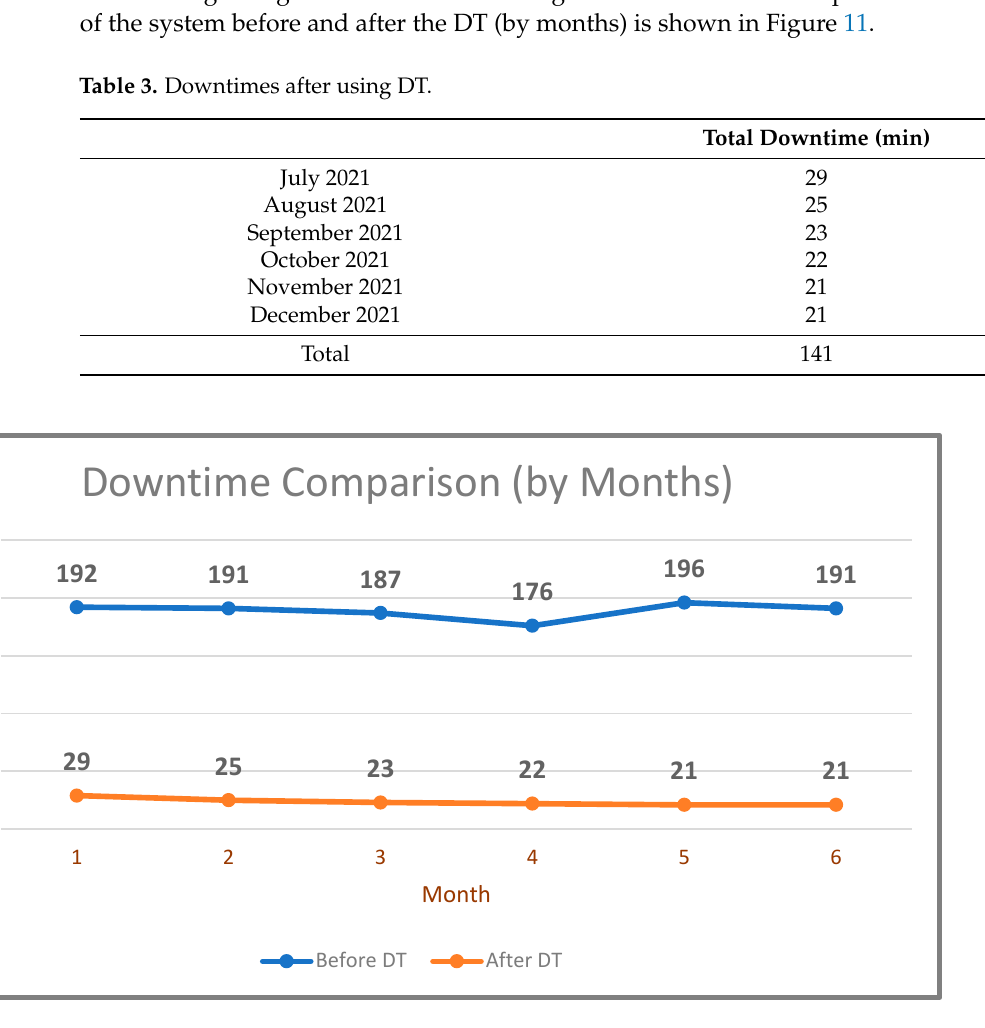
Figure 11. Minutes of downtime comparison by months (before and after DT).